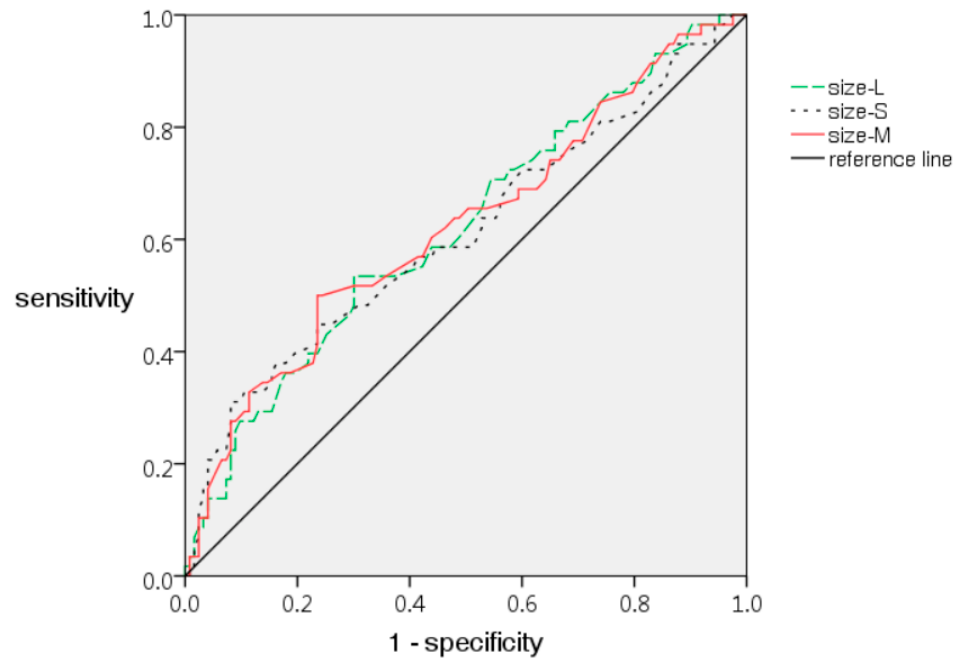
Figure 3. The receiver operating characteristic (ROC) curves of size-L, size-S, and size-M in discrimi- nating invasive adenocarcinoma from other pathological results, with the area under curve (AUC) values of 0.620, 0.614, and 0.623, respectively. Size-L: the maximal diameter in the long axis; size-S: the maximal short-axis diameter perpendicular to the long axis of nodule; size-M: the mean value of long and short axis diameters.